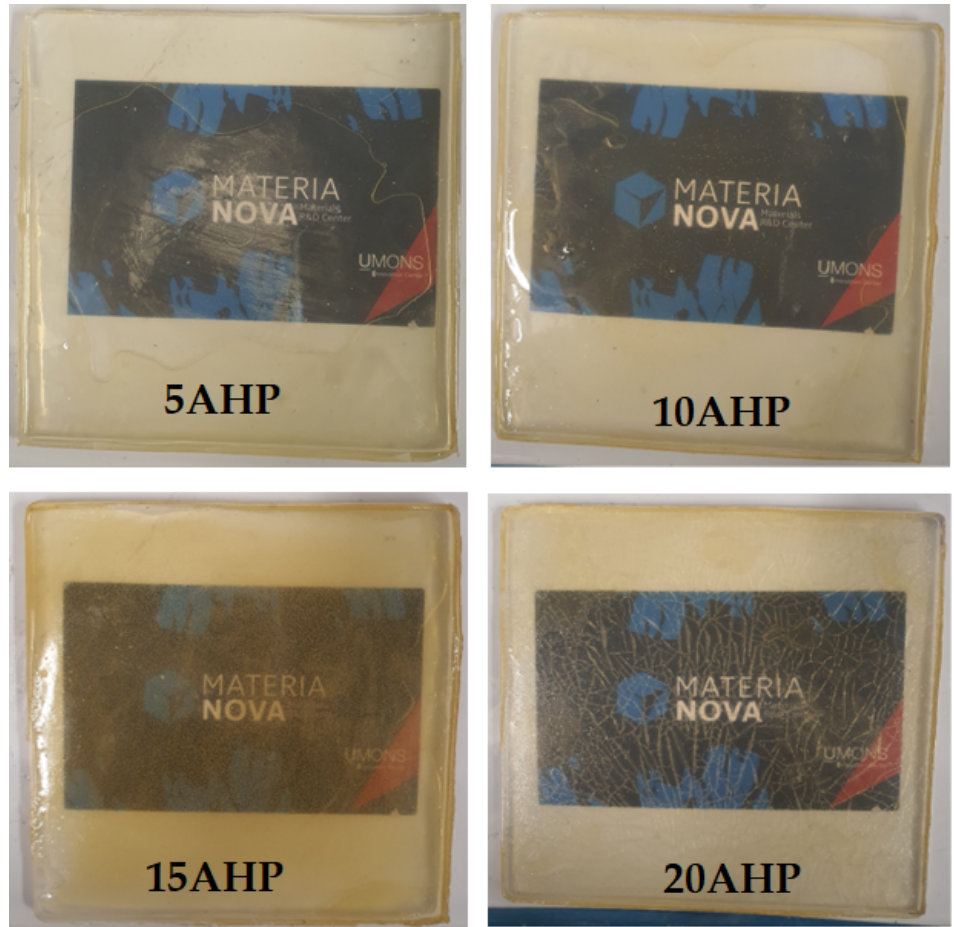
Figure 6. PLA plates surface coated with epoxy/AHP nanocomposite films containing 5, 10, 15 and 20 wt.% AHP nanoparticles.